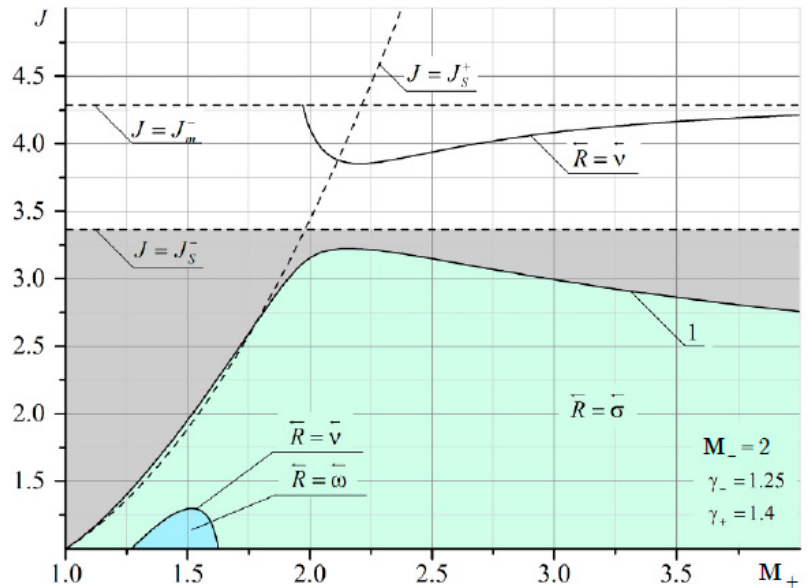
Figure A1. Domains of existence of reflected discontinuities for refraction from a gas consisting of combustion products into a diatomic gas. The Mach number of the flow from which the shock comes is M – = 2.